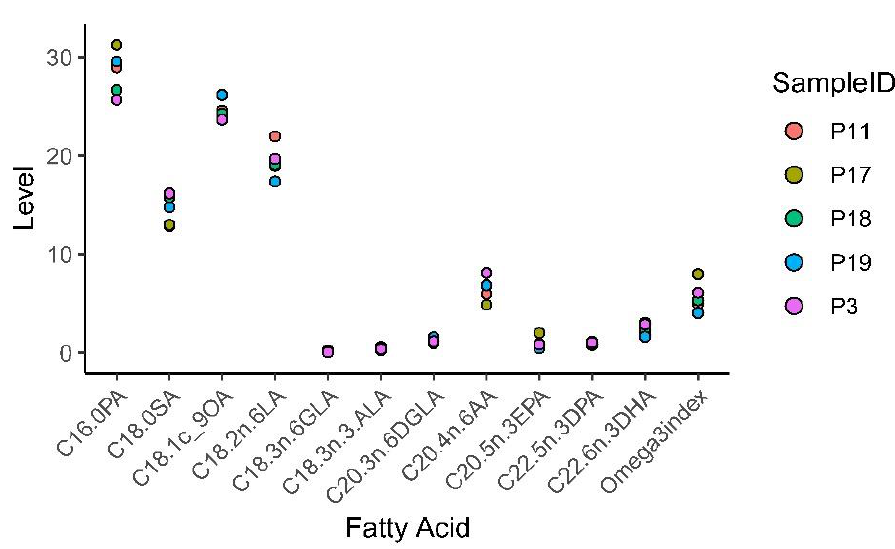
Figure 15. Patient whole blood omega-3 fatty acid (FA) profiling and Omega-3 index. Mouse blood samples were obtained before and after treatment to detect changes in blood FA content during treatment. In mice, the levels of EPA, DHA, and DPA signifi- cantly correlated with each other and the Omega-3 index as indicated in Supplementary Figure S5-1. An analysis of variance (ANOVA) on a hierarchical mixed model fitted to each FA and accounting for the measurements before and after treatment in the same mouse model, showed significant effects for oleic acid (OA), digamma linoleic acid (DGLA), arachidonic acid (AA), DPA, DHA, and the Omega-3 index (Figure 16). As ex- pected, the average content of DHA as well as the Omega-3 index were higher in whole blood from the mice receiving fish oil compared to untreated mice (included blood sam- ples from mice before treatment) as shown by a post hoc Tukey test. However, a rise in DHA content was not found in all mice within the fish oil group (mouse #22 and 27). Moreover, we also observed a trend of increased levels of DPA, DHA, and Omega-3 index for mice in the placebo group, although this was not statistically significant. The intake of